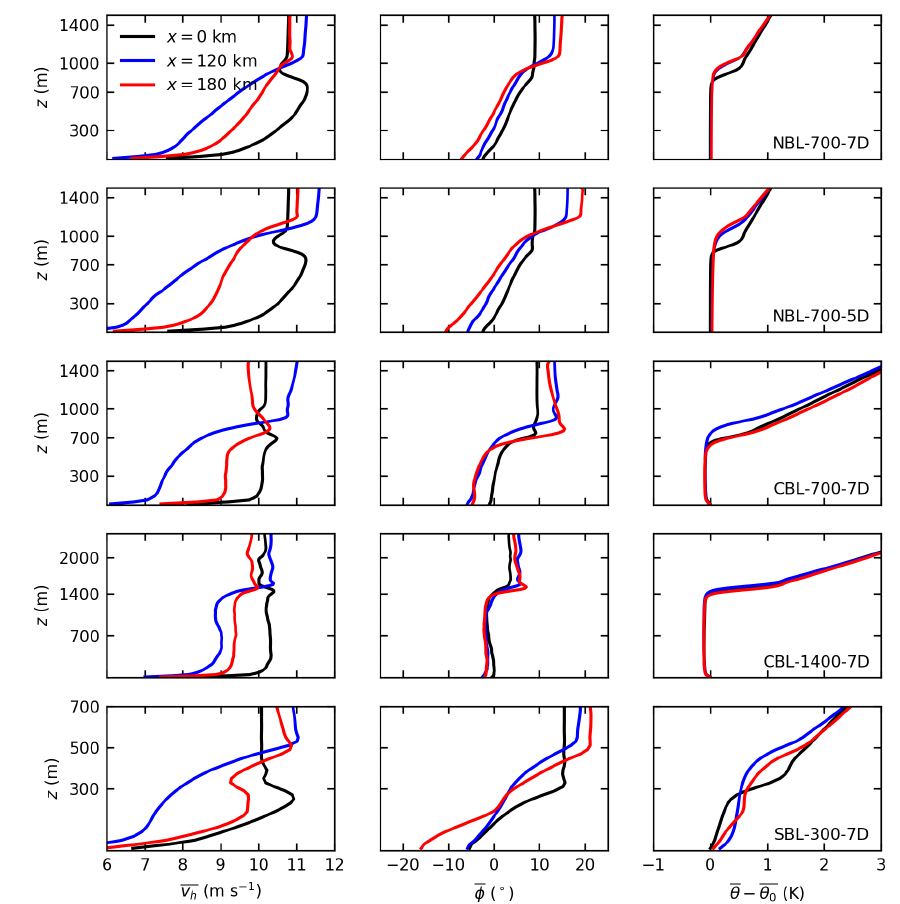
Figure 9. Vertical profiles of temporal averaged horizontal wind speed ( v h ), wind direction ( φ , clockwise positive) and potential tempera- ture ( θ ) relative to surface temperature θ 0 at the inflow ( x = 0km), in the near wake ( x = 120km) and in the far wake ( x = 180km) of the large wind farms in Zone 3 ( y = 120km) for all five cases. The wind farm trailing edge is located at x =